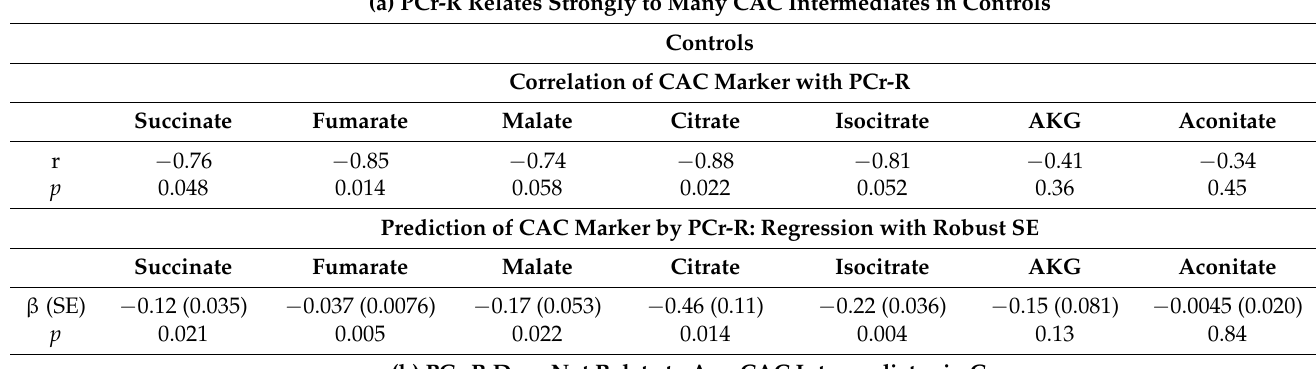
Cases Correlation of CAC Marker with